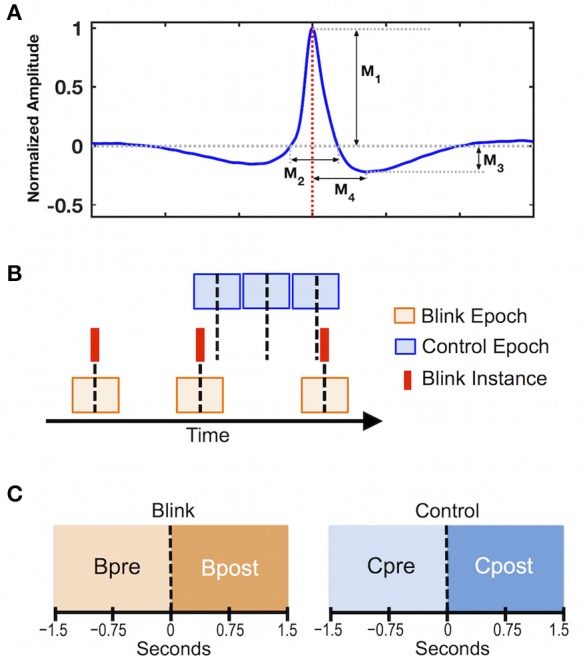
Data preprocessing steps. (A) Grand average of 3 s blink epochs in vEOG recording showing the morphological features used in behavioral evaluation. Features describe the height and width of the positive and negative portions of the blink trace. M1 = positive peak amplitude; M2 = positive peak width; M3 = negative peak amplitude; M4 = negative peak time. Red dotted line denotes latency of blink maximum or T0, corresponding to the moment when eyelids are fully closed. (B) Schematic illustration of data segmentation procedure. Blink epochs were centered at T0 (red solid lines), while control epochs were pseudo-random with respect to blink events. Number of epochs was identical between control and blink conditions for each subject. Black dotted line represents time zero for each condition. (C) Statistical contrasts were evaluated based on data in the intervals pre and post time zero for each condition (i.e., Bpost vs. Bpre for the blink condition, and Cpost vs. Cpre for the control condition).